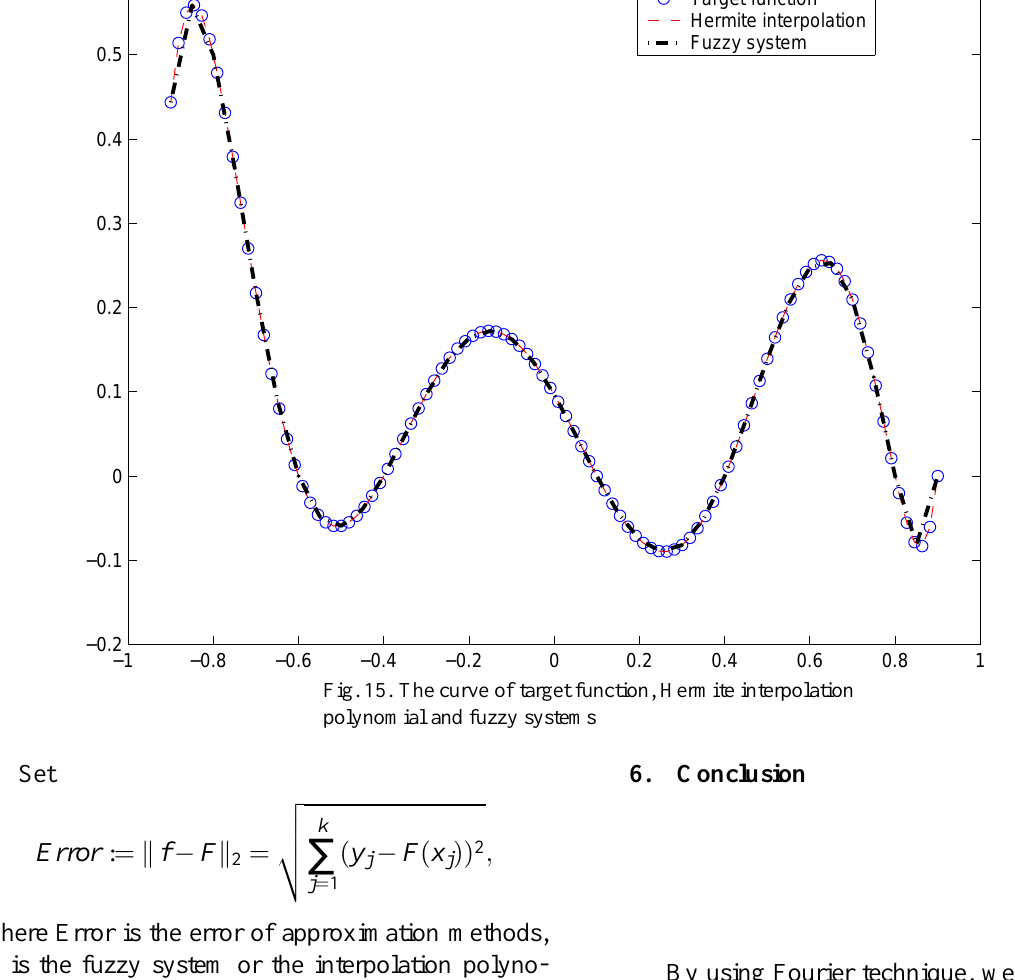
Fig. 15. The curve of target function, Hermite interpolation polynomial and fuzzy